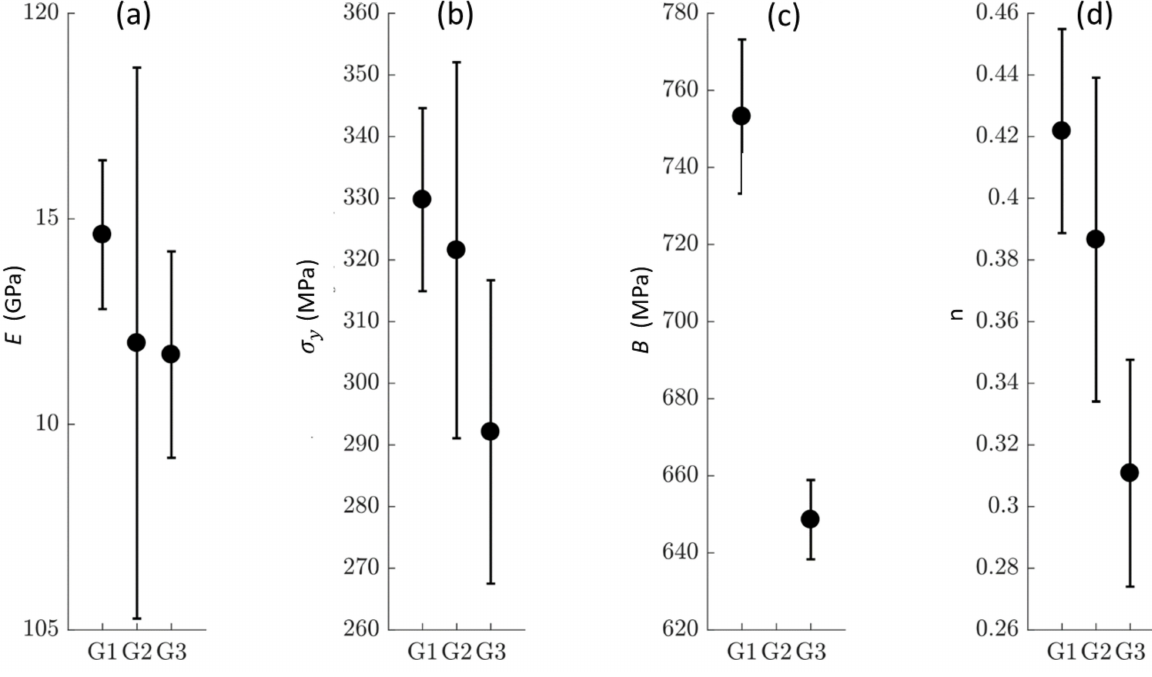
Figure 5. Identified parameters for the three groups. ( a ) E the Young’s modulus, ( b ) σ y the yield stress, ( c ) B the hardening parameter, ( d ) n the hardening